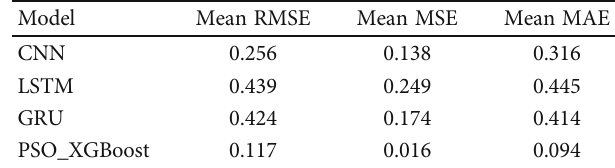
Figure 12: Cross-plot of the core permeability and predicted permeability by the various models: (a) linear regression, (b) multivariate regression, and (c) PSO-XGBoost. Table 5: Con fi guration parameters of all models. Table 6: Prediction error comparison between experiment